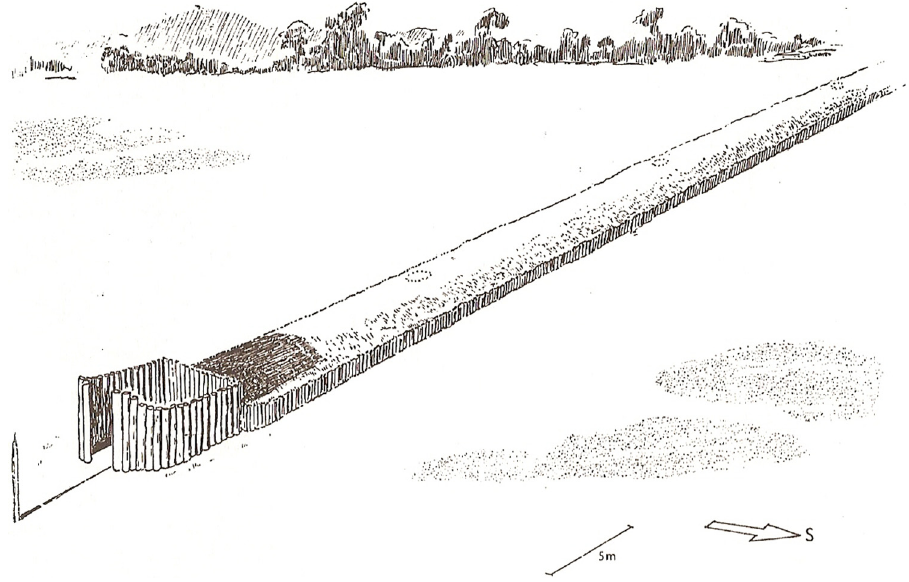
Figure 1: B ř ezno ( Louny district ) . A reconstruction of the Proto - Eneolithic burial mound ( after Pleinerová, 1980 )